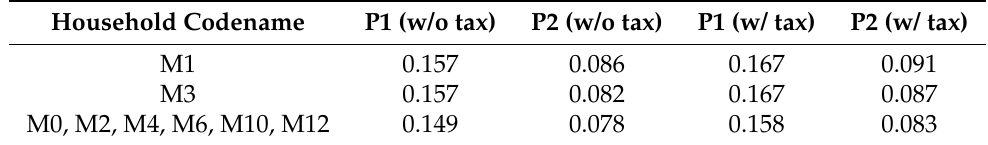
Table 2. Electric energy prices for experimental tariffs in